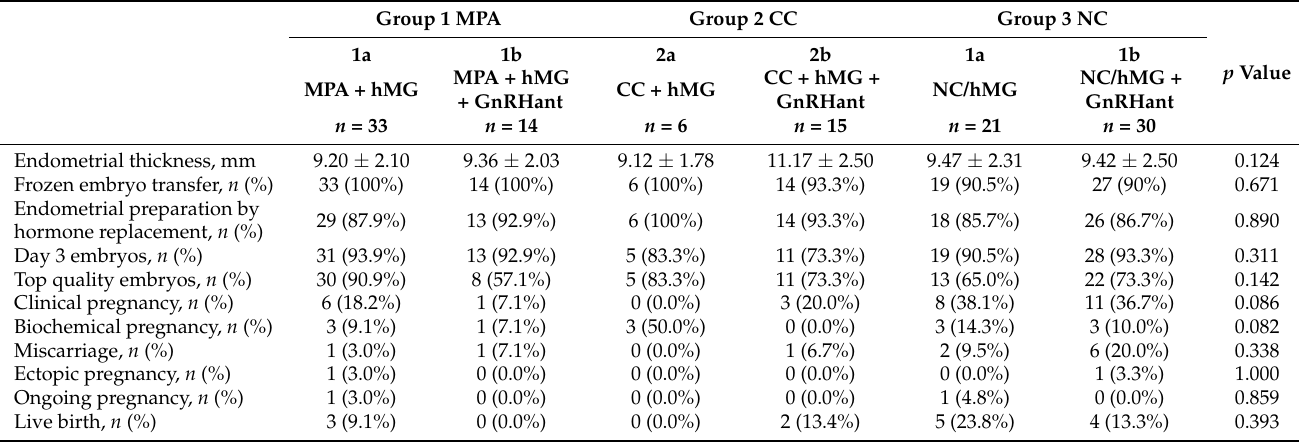
Table 3. Pregnancy outcomes of embryos originated from the